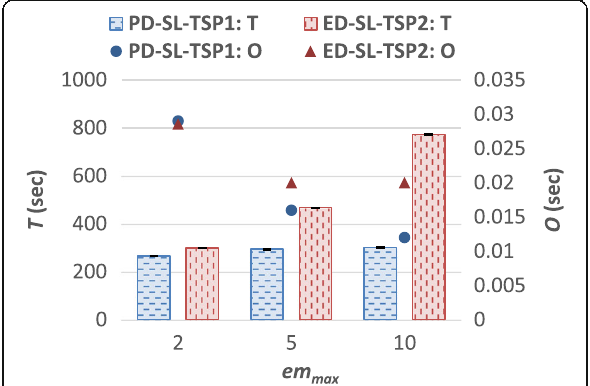
Fig. 11 Effect of em max on T and O when using the CyberShake workload